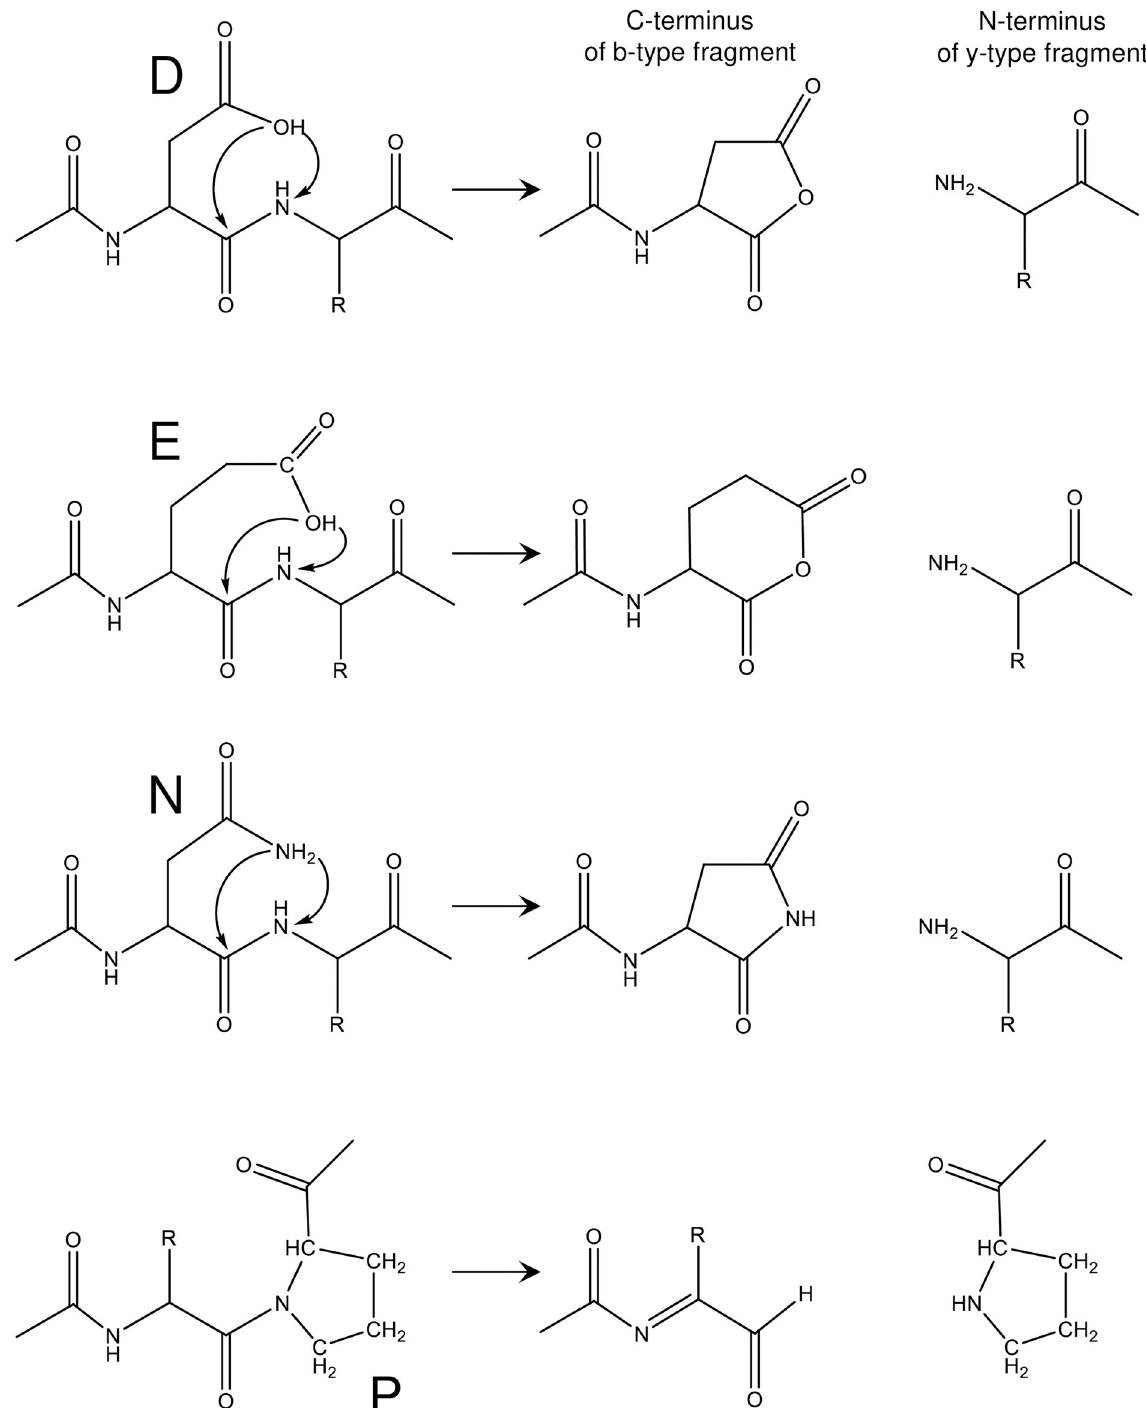
Fig 1. Schematic of the aspartic acid effect fragmentation mechanism of the polypeptide backbone cleavage on the C-terminal side of aspartic acid (D), glutamic acid (E) and asparagine (N) residues and the N-terminal side of proline (P) residues resulting in the formation of complementary b-type and y-type fragments. Whether a fragment is neutral or ionized depends on which basic residue of the protein precursor ion is sequestering the ionizing proton.